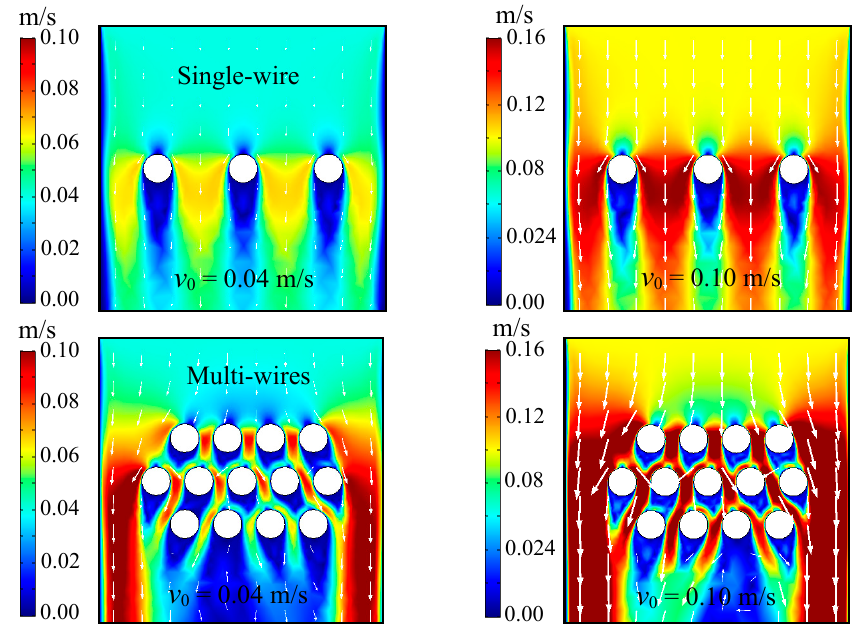
Figure 4. Fluid characteristics around single-wire ( above ) and multi-wires ( below ).